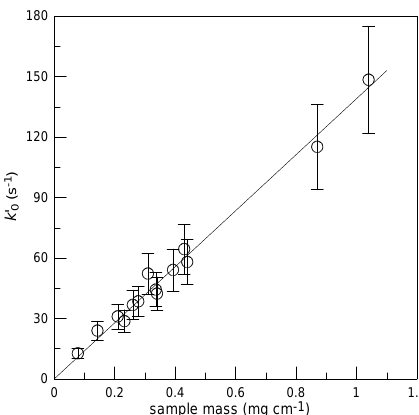
Fig. 6. Uptake coefficient as function of the initial concentra- tion of NO 2 : T = 280K, P = 9Torr, J NO mass=0.32mgcm − 1 . Error bars represent estimated 20% uncer- tainty on the measurements of γ